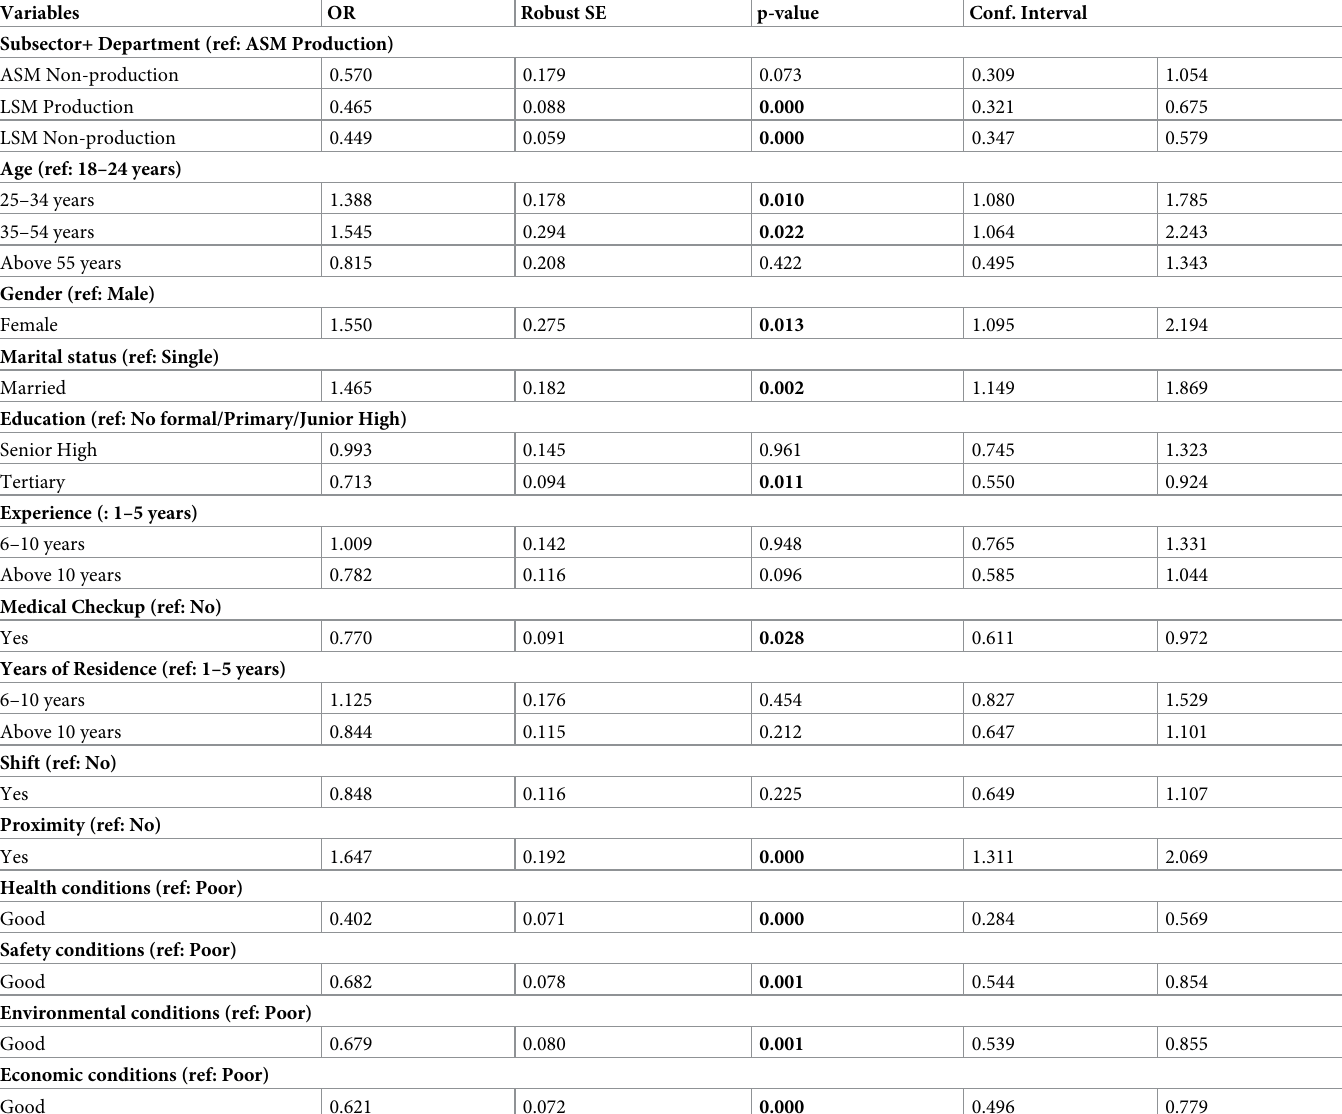
Table 2. Bivariate negative log-log regression of experiencing occupational related health problems by